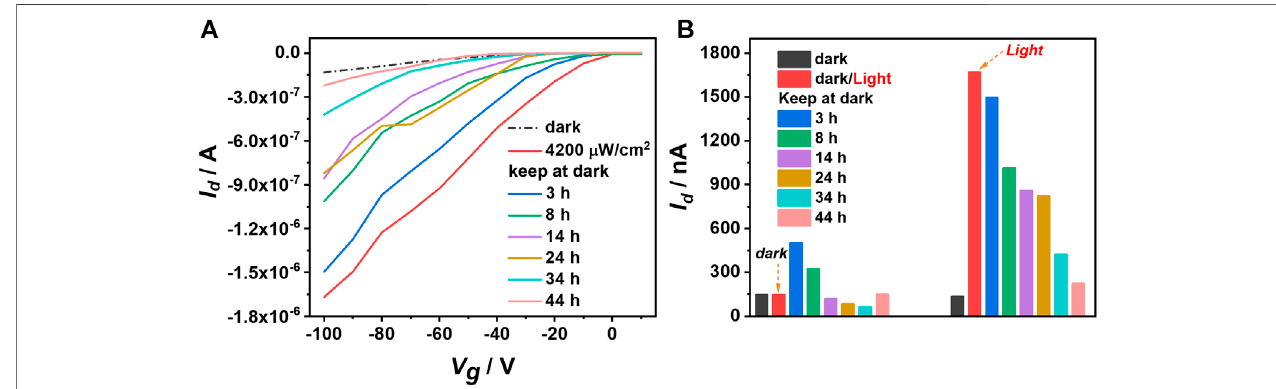
FIGURE 4 | (A) Transfer curves of the photocurrent retention characteristics for IDTOT-4F based optoelectrical devices ( V d (cid:2) − 100 V); (B) Histogram contrast between the memory behaviors of the dark current and the photocurrent.